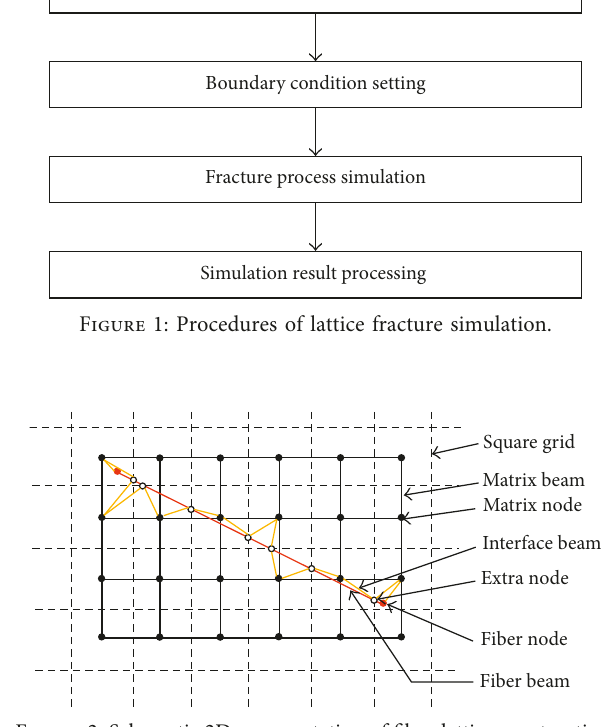
Figure 2: Schematic 2D representation of fiber-lattice